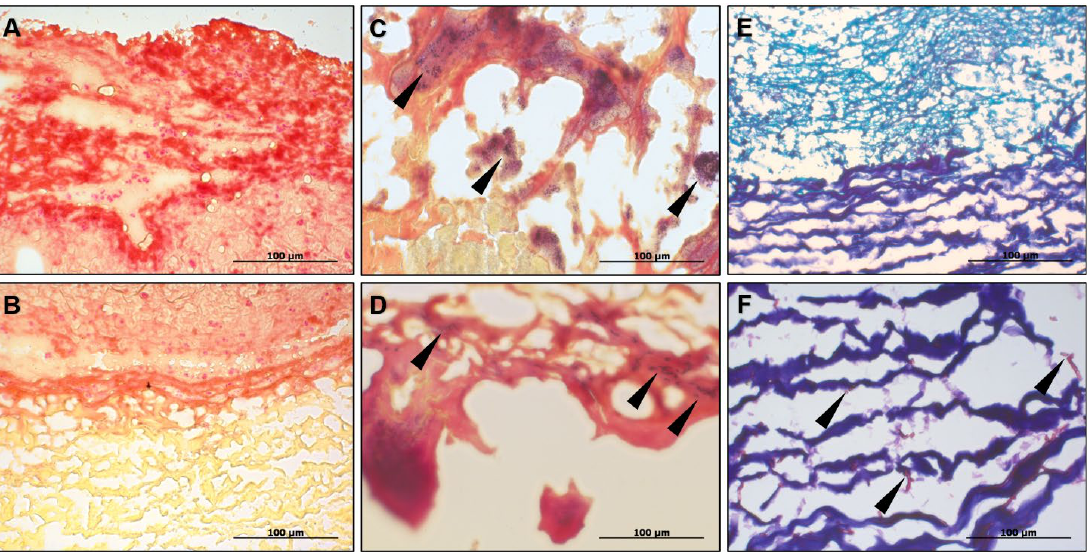
Figure 5. Immunothrombosis of BHV is not related to prosthetic valve endocarditis. ( A ) Negative Gram staining of the clot at the prosthetic surface. Magnification × 400. Scale bar = 100 µ m; ( B ) Negative Gram staining of the clot and underlying prosthetic tissues. Magnification × 400. Scale bar = 100 µ m; ( C ) Positive control for Gram staining (bacterial vegetations on the leaflet excised from the patient with prosthetic valve endocarditis). Black arrows indicate bacteria. Magnification × 400. Scale bar = 100 µ m; ( D ) Positive control for Gram staining (bacteria within the microthrombi on the leaflet surface excised from the patient with prosthetic valve endocarditis). Black arrows indicate bacteria. Magnification × 400. Scale bar = 100 µ m; ( E ) Negative periodic acid–Schiff staining of the clot and underlying prosthetic tissues. Magnification × 400. Scale bar = 100 µ m; ( F ) Positive control for periodic acid–Schiff staining (intact bovine pericardium intentionally contaminated with the fungi). Black arrows indicate the fungi. Magnification × 400. Scale bar = 100 µ